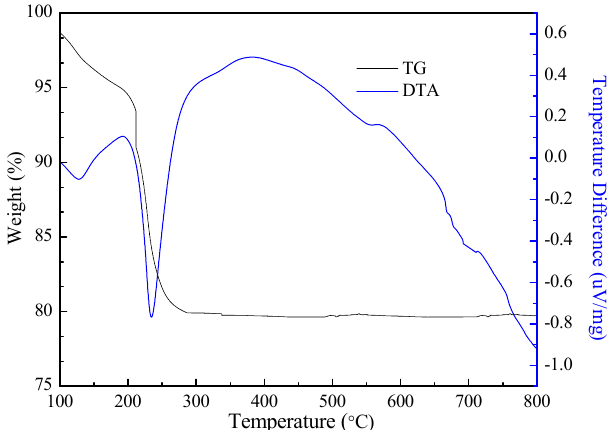
Figure 11. Thermal (TG-DTA) analysis of the VO(OH) 2 in argon atmosphere.